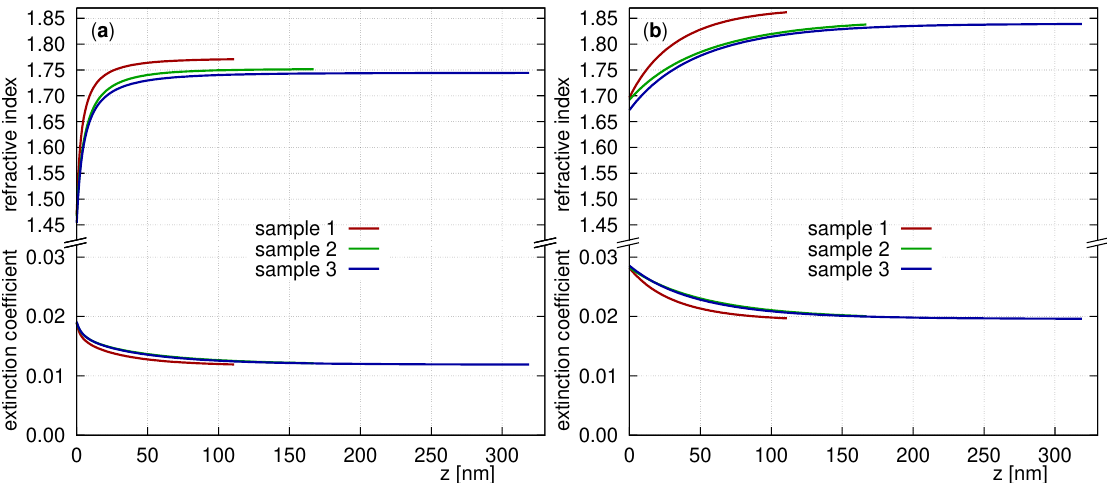
Figure 4. The profiles of the optical constants of the inhomogeneous films of refractive index for the selected photon energy E = 2.5eV (496nm) for: ordinary wave ( a ); and extraordinary wave ( b ). The coordinate z is directed such that it corresponds to the depth inside the inhomogeneous films (i.e., the distance form the upper boundary).